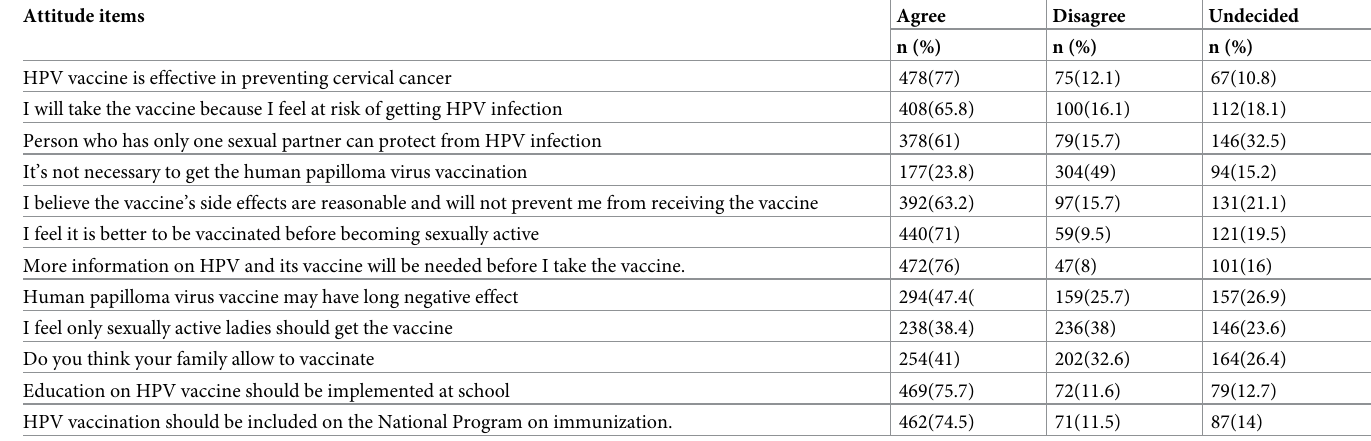
Table 3. Attitude toward HPV vaccination among female preparatory school students, Bahir Dar, Ethiopia, 2021(n = 620). Attitude